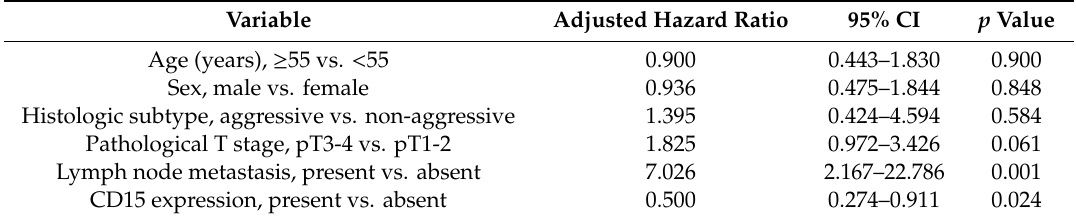
Table 2. Multivariate Cox regression analysis of recurrence-free survival in 467 patients with papillary thyroid carcinoma treated with total thyroidectomy and radioiodine remnant ablation.